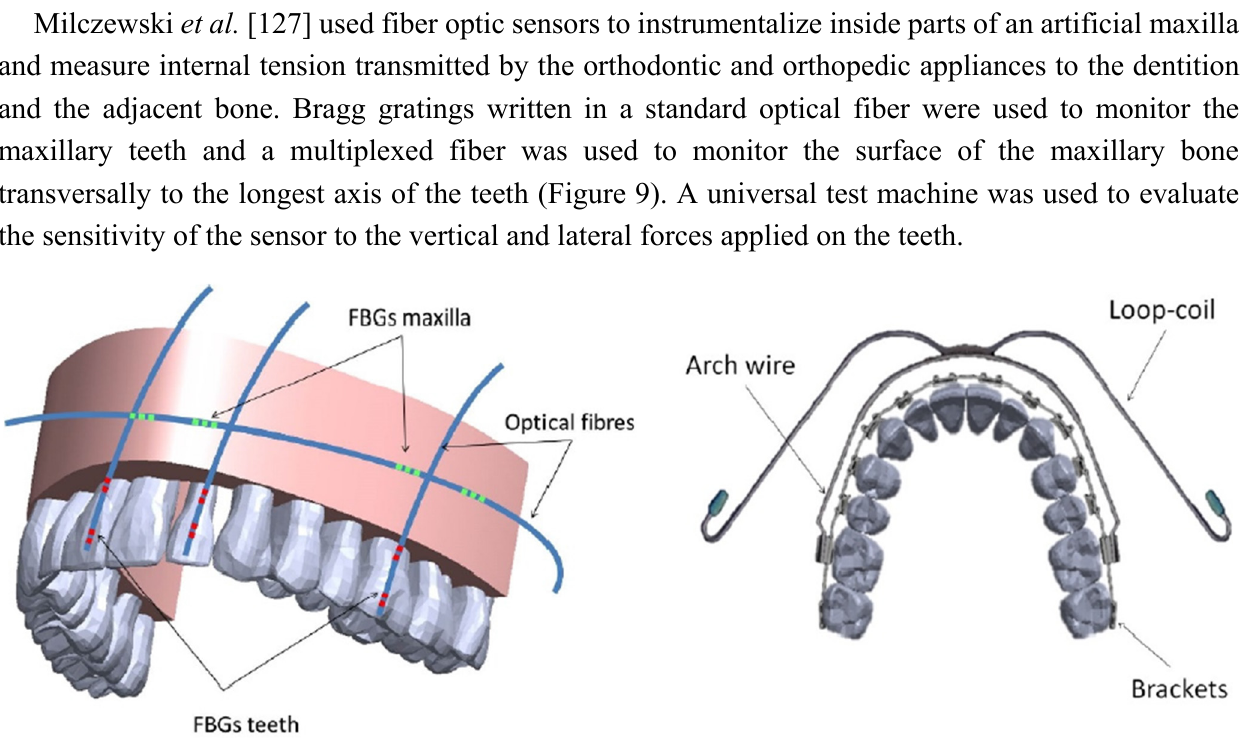
Figure 9. Left : Schematic representation of the maxilla model instrumented with FBG sensors; Right : Occlusal image of the teeth with fixed appliance and extra-oral device (adapted from